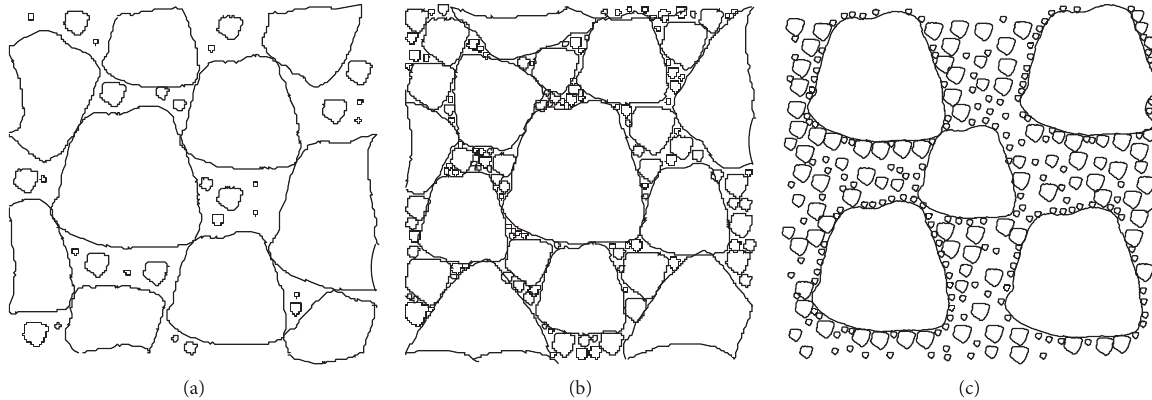
Figure 14: Three kinds of soil structures of coarse-grained soils: (a) void-existed skeleton structure; (b) densely filled skeleton structure; (c) suspended skeleton